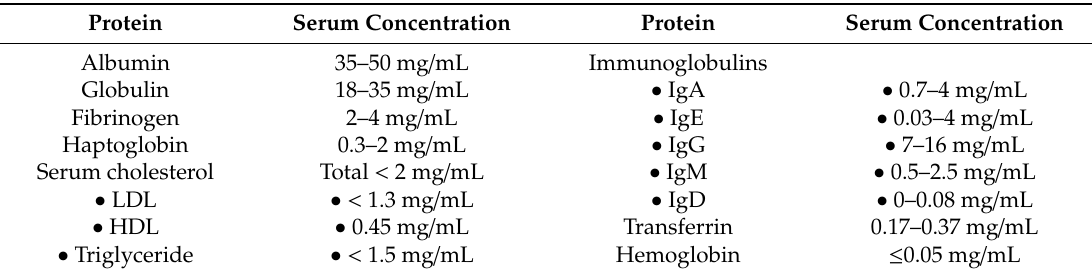
Table 2. Most abundant proteins in human serum [67–69].